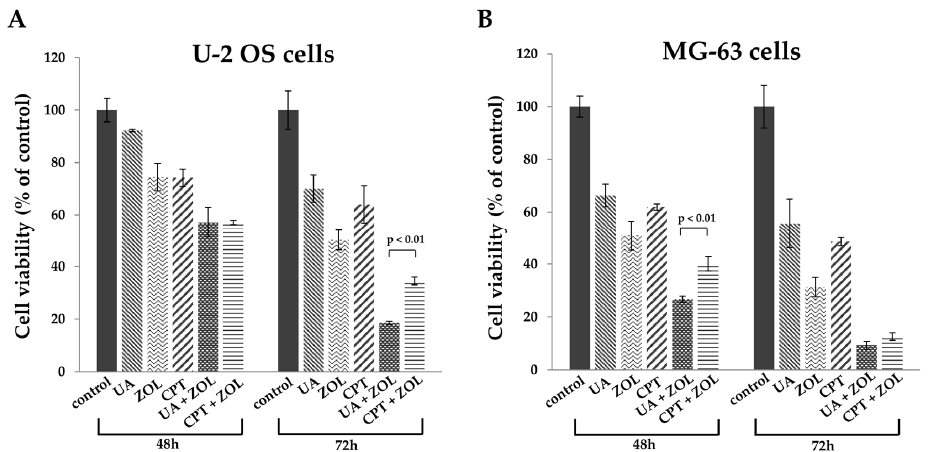
Figure 2. Zoledronic acid enhances ursolic acid-mediated inhibition of cell viability. MTT assays were performed with U-2 OS cells ( A ) or MG-63 cells; ( B ) treated with either ZOL (10 μ M), UA (20 μ M), CPT (5 μ M) or a combination of ZOL/UA, or ZOL/CPT at different time points. Three independent experiments were conducted.